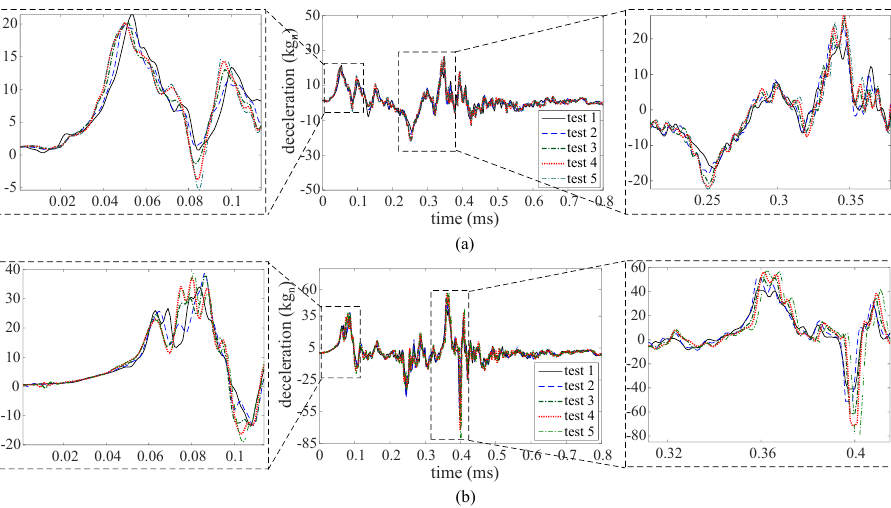
Figure 5. Deceleration time series obtained from five consecutive tests: ( a ) TS 1 ; and ( b ) TS 2